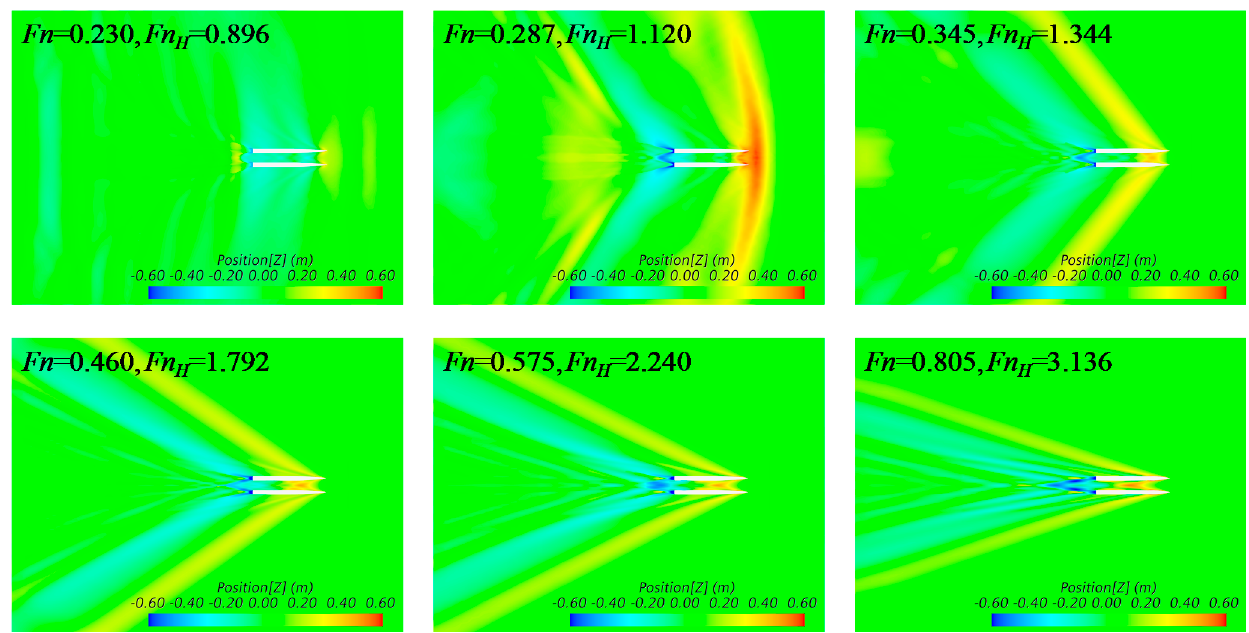
Figure 13. Wave patterns created by the London Demonstrator in shallow water.